Question: What style of plot is this figure drawn as?
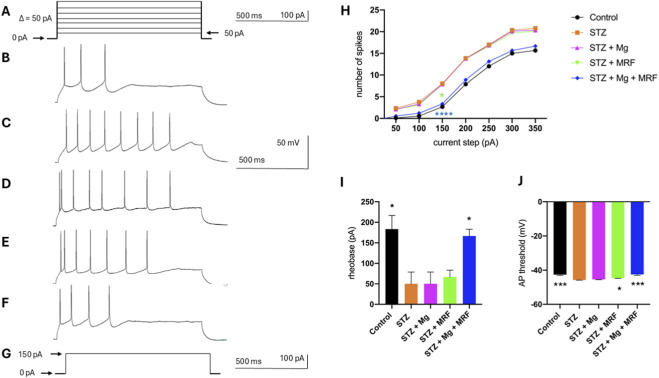
Answer: bar